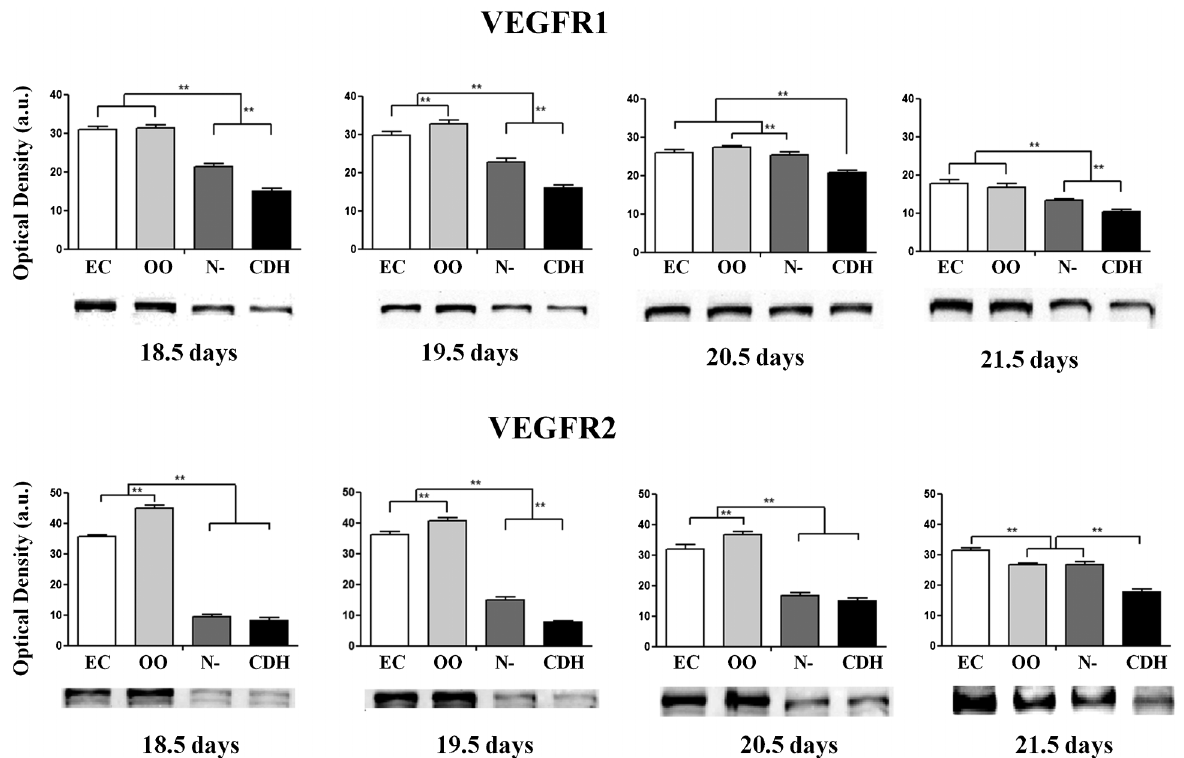
Figure 3. Evolution of vascular endothelial growth factor receptors (VEGFR1 and VEGFR2) at 18.5, 19.5, 20.5, and 21.5 days of gestation. EC: external control; OO: exposed to olive oil; N-: exposed to nitrofen without CDH; CDH: exposed to nitrofen with CDH. **P , 0.001 (analysis of variance with Tukey-Kramer post hoc